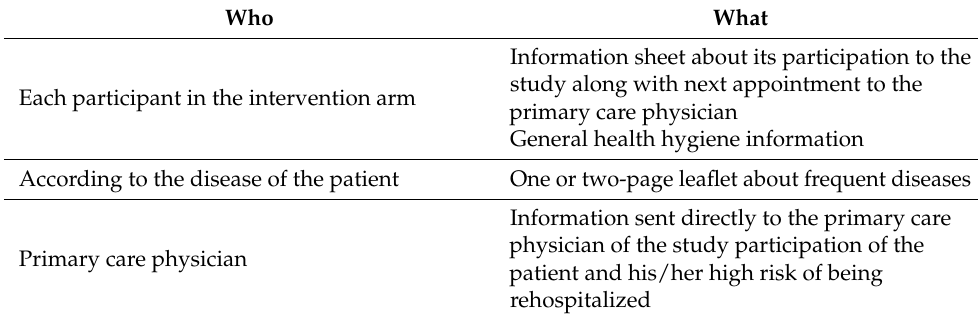
Table 4. Documents transmitted in the intervention group (available as Supplementary